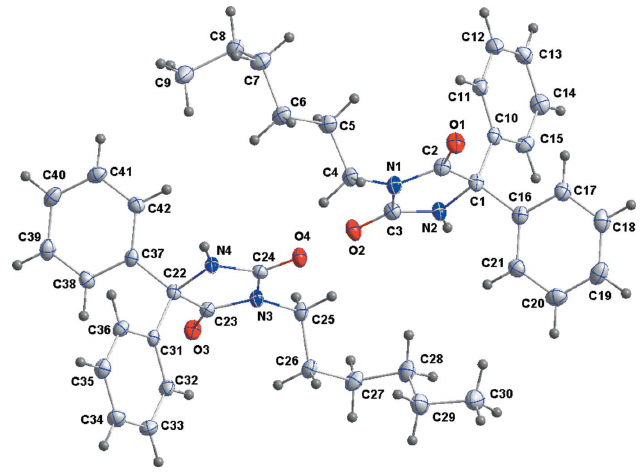
Figure 1 The asymmetric unit with labelling scheme and 50% probability